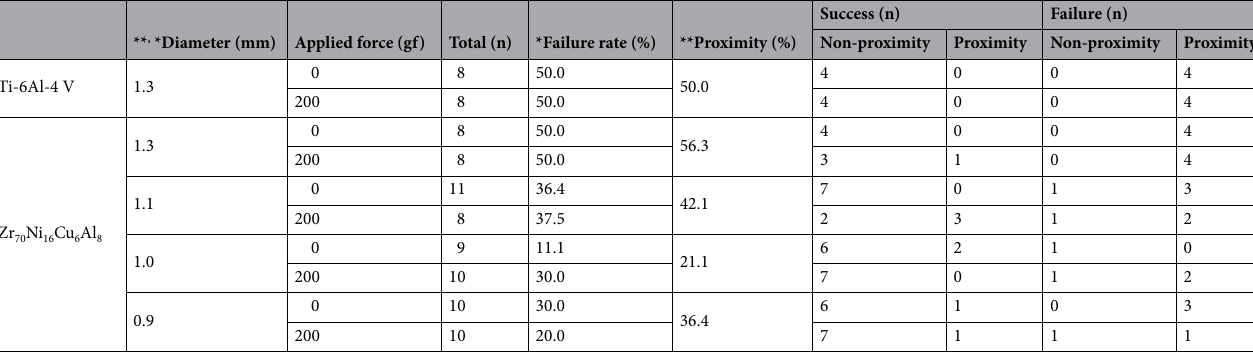
Table 1. Evaluation of miniscrew failures and root proximity. ** P < 0.01 diameter vs failure rate by Pearson’s correlation coefficient test. * P < 0.05; diameter vs proximity by Pearson’s correlation coefficient test.